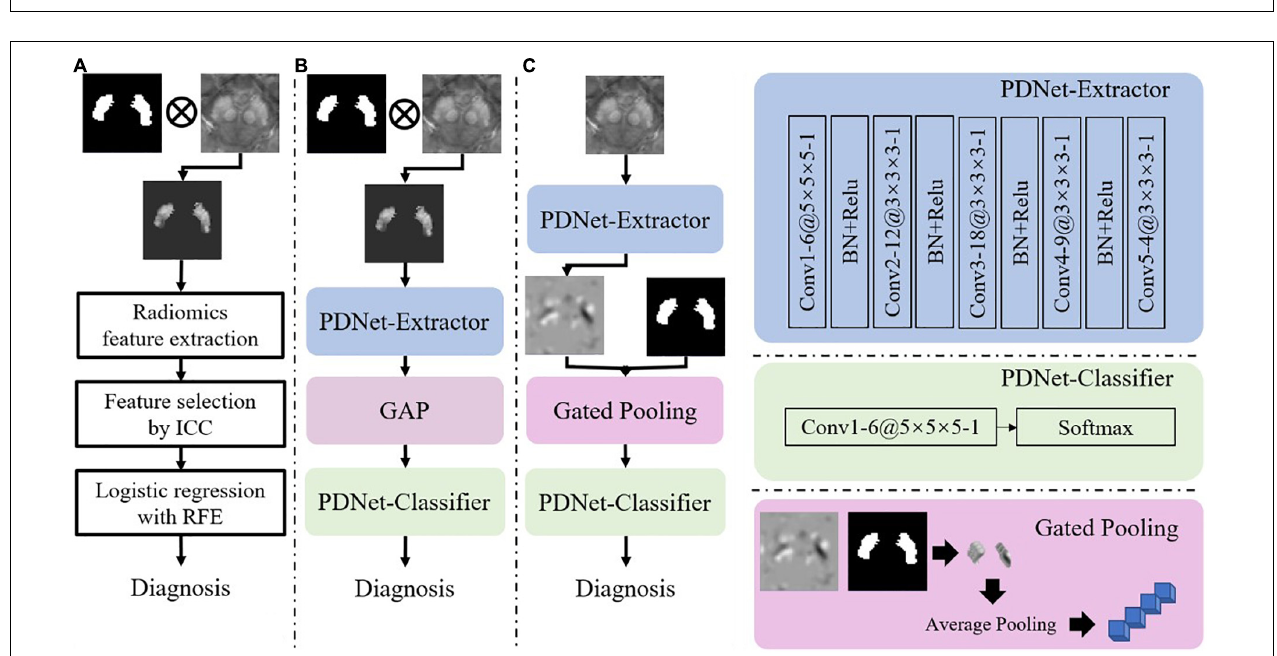
FIGURE 3 | Examples of the substantia nigra labels in different sets.